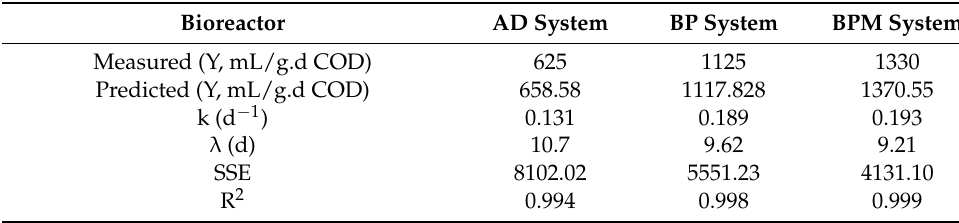
Table 3. Summary of modified Gompertz kinetic model